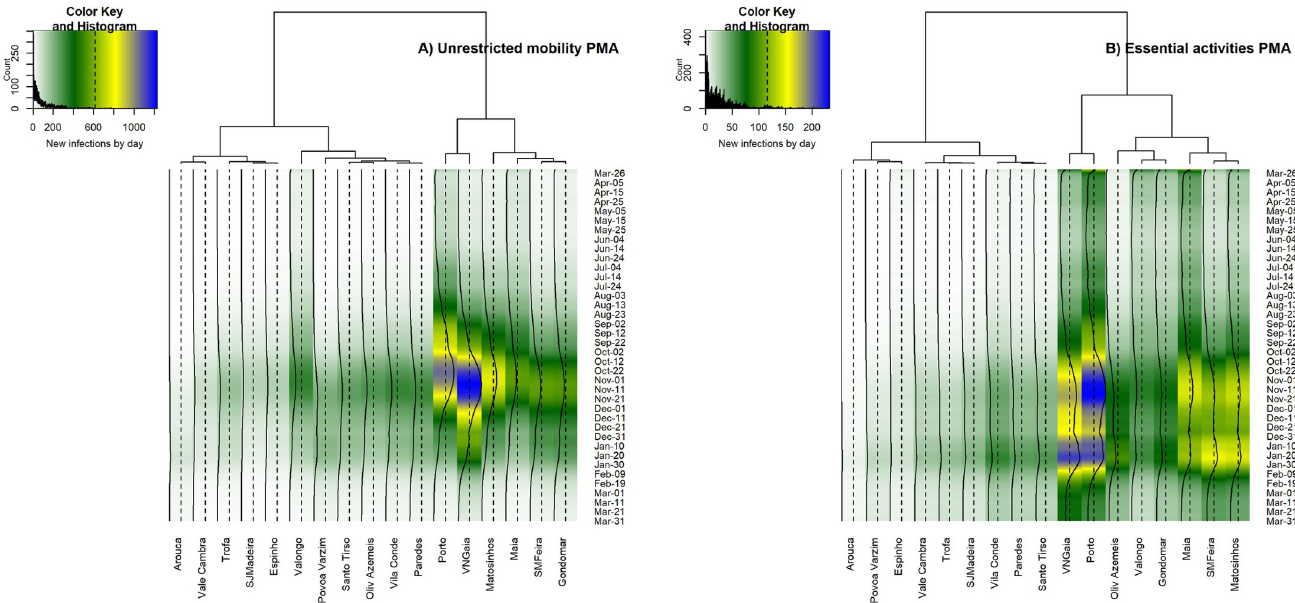
Fig 8. Time-series clustering of the daily new infected in the municipalities of PMA, for the simulation regarding the unrestricted mobility of 2011 (A, left) and restricted to essential activities (B, right). The color key is the same for both metropolitan areas and mobility scenarios, to facilitate visual comparisons, but the range of values (new infections by day) differs. Obtained with dtwclust package in R software [37].